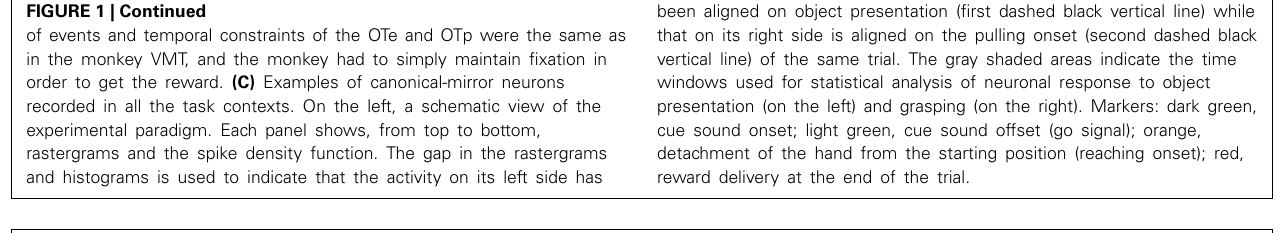
been aligned on object presentation (first dashed black vertical line) while that on its right side is aligned on the pulling onset (second dashed black vertical line) of the same trial. The gray shaded areas indicate the time windows used for statistical analysis of neuronal response to object presentation (on the left) and grasping (on the right). Markers: dark green, cue sound onset; light green, cue sound offset (go signal); orange,